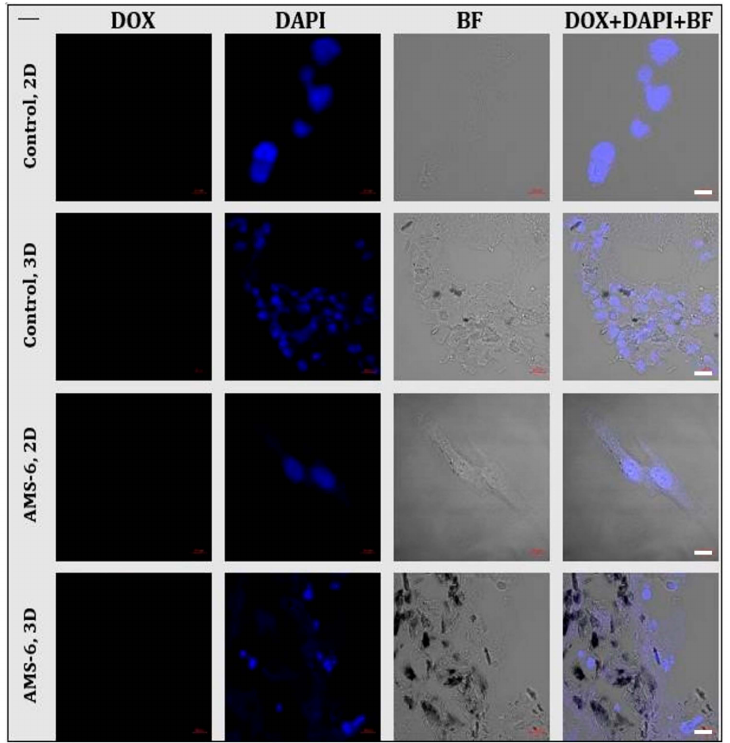
Figure A22. Laser-scanning confocal fluorescence microscopy images 2D and 3D TECs in vitro cultures of MDA-MB-231 cells incubated with complete culture medium (control 2D and 3D) and pure (not loaded with Dox) AMS-6 nanoparticles for 24 h. Note the absence of Dox fluorescence in the red channel (Dox), the clear association of DAPI fluorescence staining with cell nuclei (blue channel, DAPI). AMS-6 concentration, 50 µ g/mL. Scale bars: Control and AMS-6, 2D: 10 µ m; Control and AMS-6, 3D: 20 µ m.